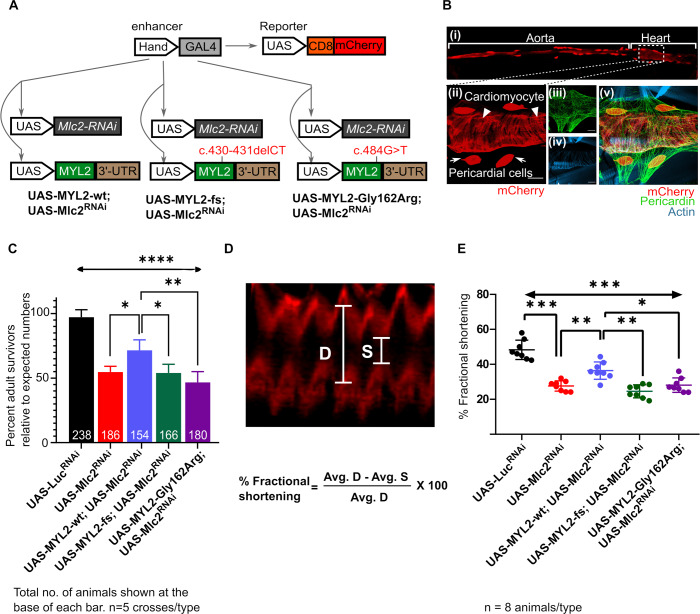
In vivo functional analysis of MYL2 variants using Drosophila Mlc2 substitution assay in the heart.(A) Schematic shows Hand-enhancer driven GAL4 (Hand-GAL4) that was used to knockdown Mlc2 expression by RNAi in the heart and to overexpress human MYL2-wt and variant cDNAs for functional substitution. In parallel, the Hand-GAL4 drives the expression of UAS-CD8.mCherry, which facilitates the visualization of the heart. (B-i) Immunofluorescence image of the Drosophila heart from UAS-CD8.mCherry. Hand-GAL4 animals show expression of mCherry in the heart chambers and aorta. (B-ii) Magnified image of the A7-A8 posterior denticle band region showing expression of mCherry in both cardiomyocytes (arrowheads) as well as pericardial cells (arrows). The expression of pericardin is shown (green, B-iii). Actin expression (blue, B-iv) shows neighboring skeletal muscles (actin is stained with phalloidin). (B-v) Merged image of the three channels. No expression of mCherry was detected in the skeletal muscle. (C) Graph showing percent of progeny that emerge as adults compared to expected numbers following Mlc2 RNAi knockdown using Hand-GAL4, and rescue by overexpression of human MYL2-wildtype (wt) and variants. Partial rescue of the lethality is observed with wt MYL2 cDNA overexpression while no significant difference is observed for the tested variants. Significance is analyzed using Brown-Forsythe and Welch ANOVA across all samples followed by multiple comparisons using Games-Howell multiple comparison test. Significance is indicated using * adj. P-Value < 0.05, ** adj. P-Value < 0.01, **** adj. P-Value < 0.0001. (D) Image showing the rhythmic pattern of cardiac contraction that was observed using UAS-CD8-mCherry reporter driven by Hand-GAL4. Diastolic width is shown by ‘D’, and systolic width by ‘S’. The formula used to calculate fractional shortening is shown. (E) Interleaved scatter plot showing fractional shortening across different genotypes (S1–S5 Movies). Fractional shortening was significantly reduced due to Mlc2 RNAi knockdown which is partially rescued by overexpression of wt human MYL2. The missense and fs variants showed no significant improvement in fractional shortening compared to the wt. Significance was calculated using two-way ANOVA followed by Tukey’s multiple comparison tests. Multiplicity adjusted P-Values of Tukey’s comparison are indicated as * adj. P-Value < 0.05, ** adj. P-Value < 0.01, *** adj. P-Value < 0.001, **** adj.P-Value < 0.0001.